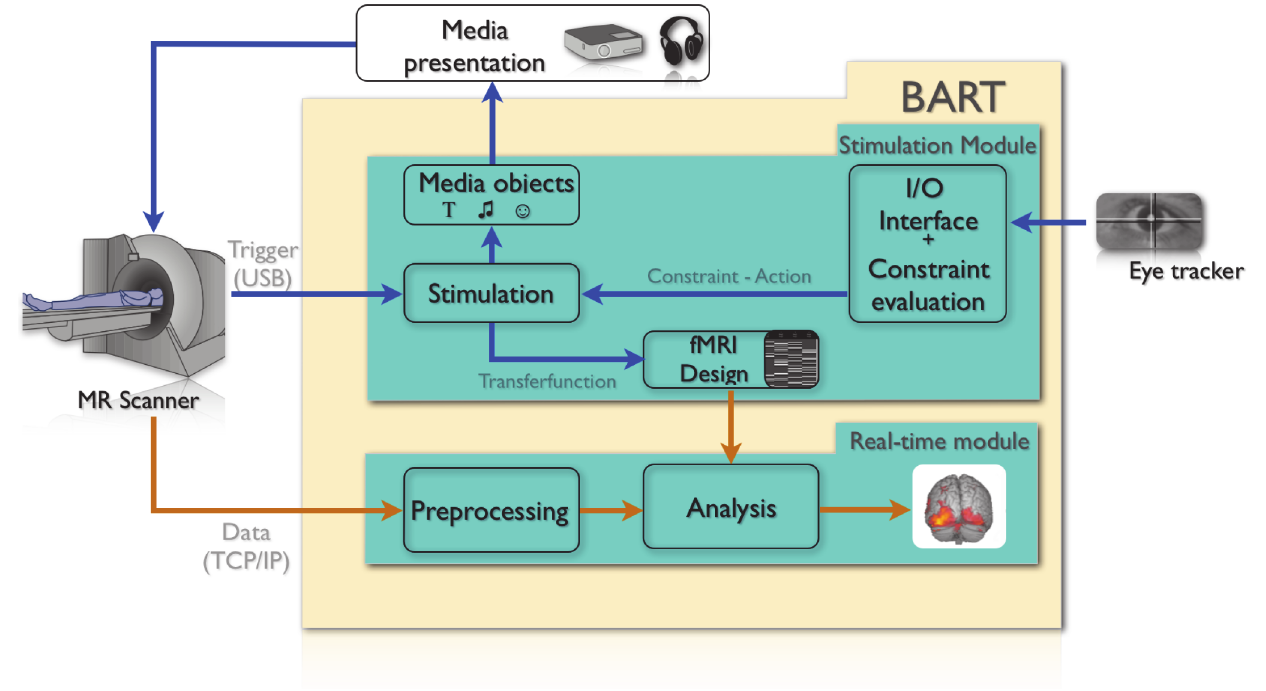
Fig 1. Schematic overview of the software package BART. Shown are the modules each running as a separate and independent process, responsible for the inclusion of behavioral/physiological parameters, the adaptation of the stimulation, design generation (blue arrows), and fMRI data processing (orange arrows). In the context of the presented study, we used an eye tracker to adapt visually presented emotional pictures according to subjects ’ fixation on the center of the screen. The plugin mechanism also allows for straightforward and flexible extension to other devices, like ECG, pulse or